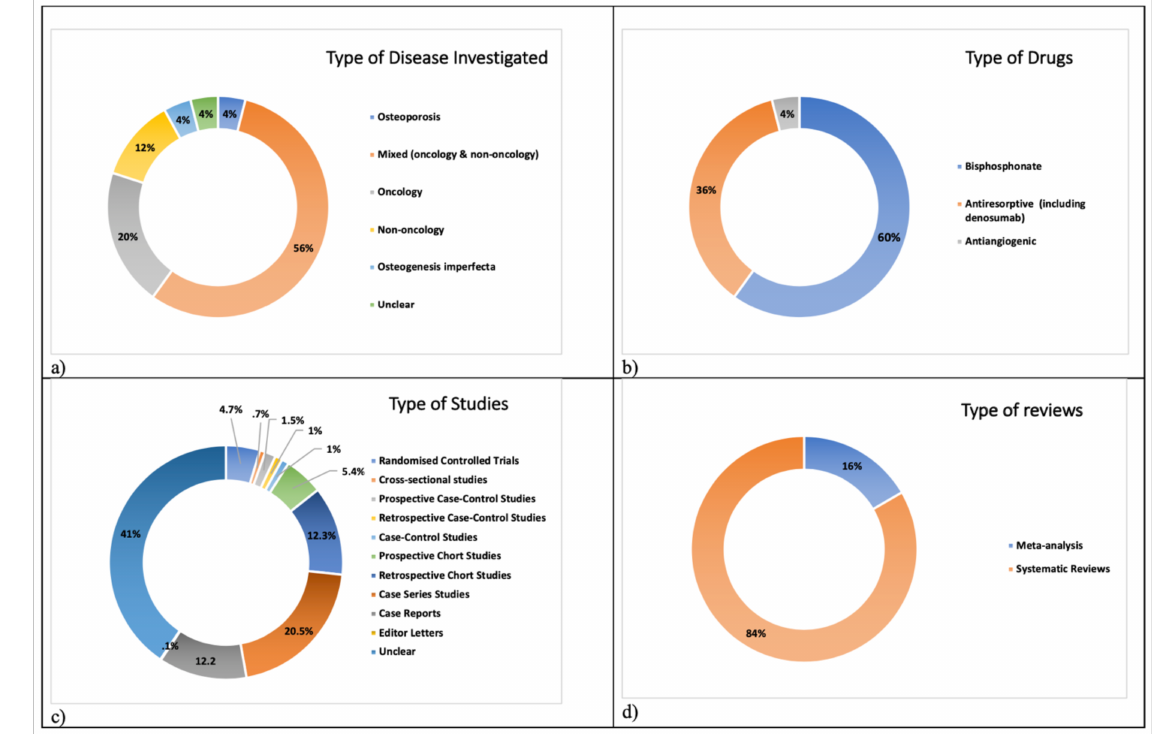
Figure 2. Overview of the study characteristics: ( a ) type of the disease analyzed in the reviews included in the study; ( b ) type of drugs analyzed in the reviews included in the study; ( c ) type of studies analyzed in the reviews included in the study; ( d ) type of reviews included in the study. Table 4. Results from included